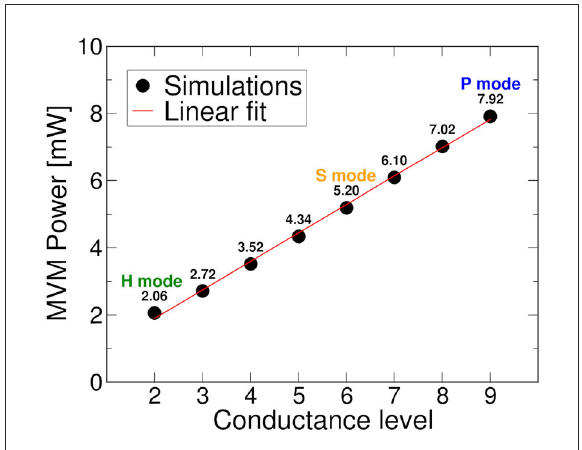
FIGURE11 Power consumption for MVM operation as a function of the conductance level selected as starting point for differential weight computation.